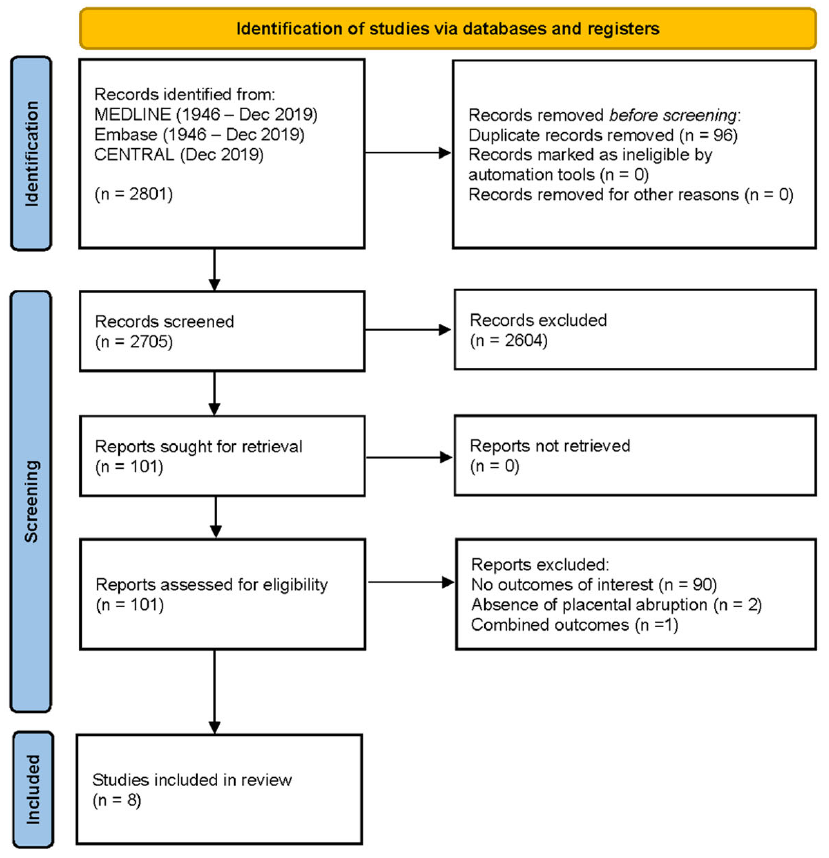
Figure 1. PRISMA flow